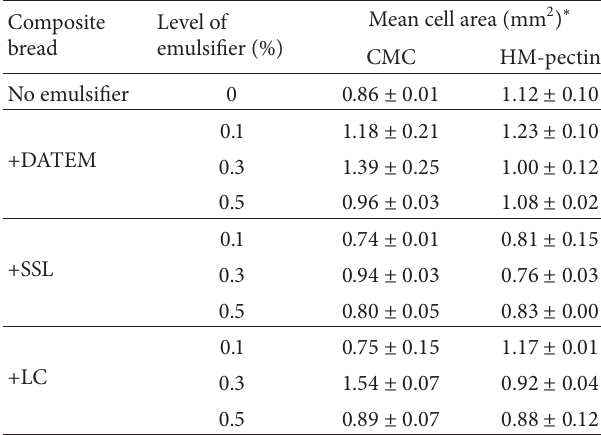
Table 4: Mean cell area of composite cassava-maize-wheat (CMW) bread as affected by the hydrocolloids (CMC and HM pectin) and emulsifier types (DATEM, SSL, and LC) at different levels of